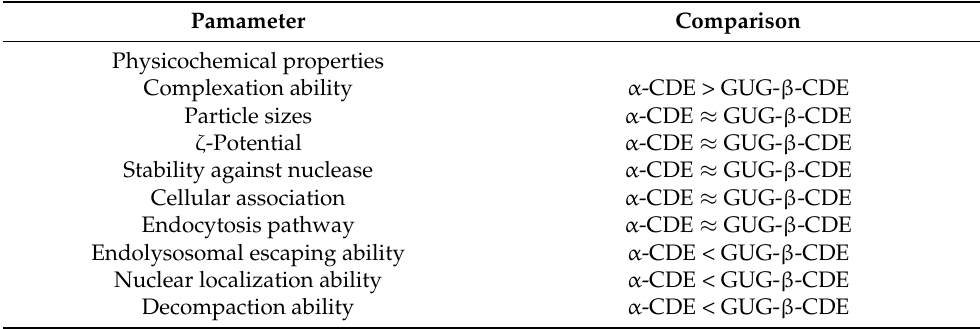
Table 2. Comparison of α -CDE and GUG- β -CDE as carriers for gene, oligonucleotides, and other